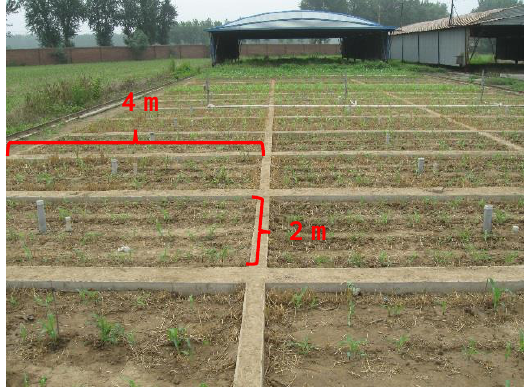
Figure 1. Photo 2 × 4 m experimental plots and large electric precipitation control shelters at Gucheng Ecological and Agricultural Research Station, Chinese Academy